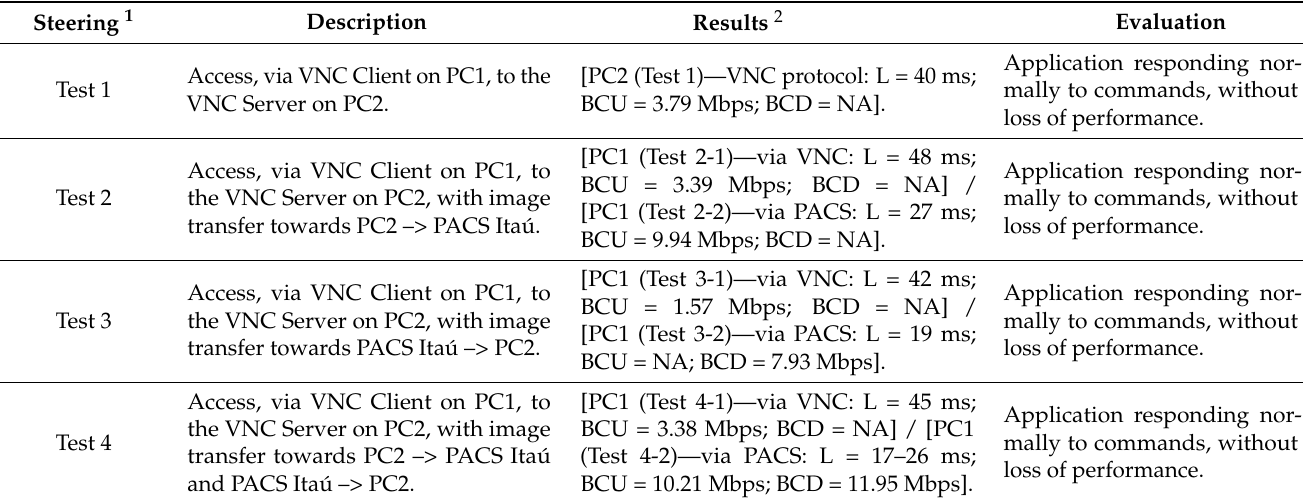
Table 2. Tests results with sVC in